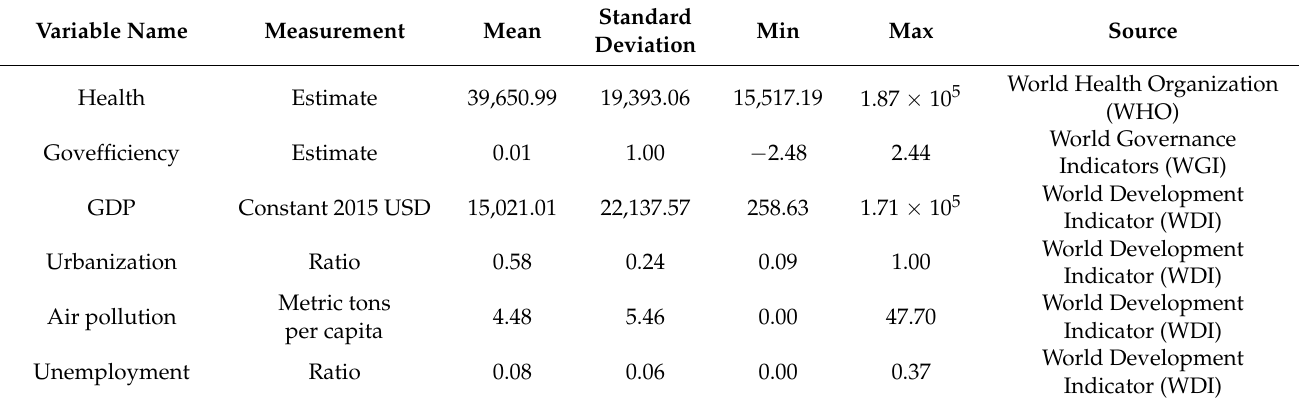
Table 1. Descriptive statistics of full